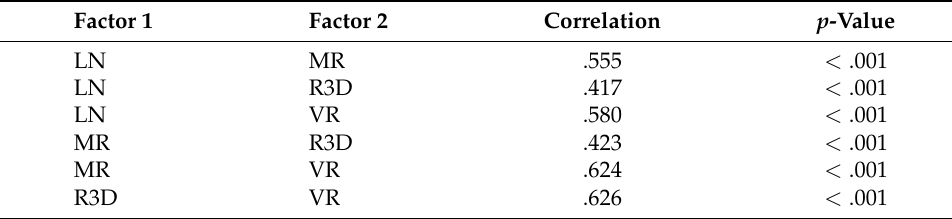
Table A2. Latent factor correlations for the ICAR-16 in the current sample.